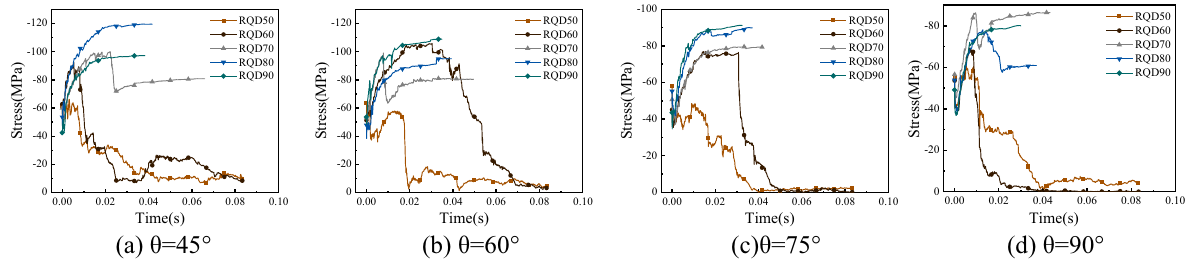
Fig. 14 Tangential stress with different RQD values in the same inclined angles of joints ( σ